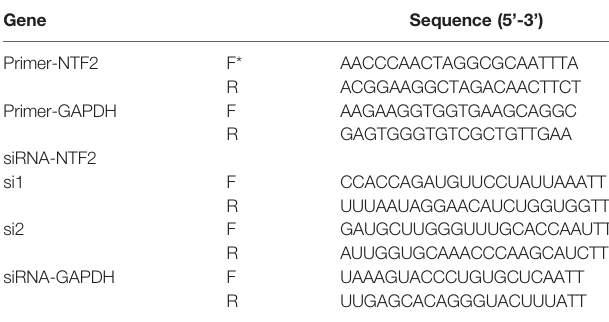
TABLE 1 | Primer and siRNA sequences of related